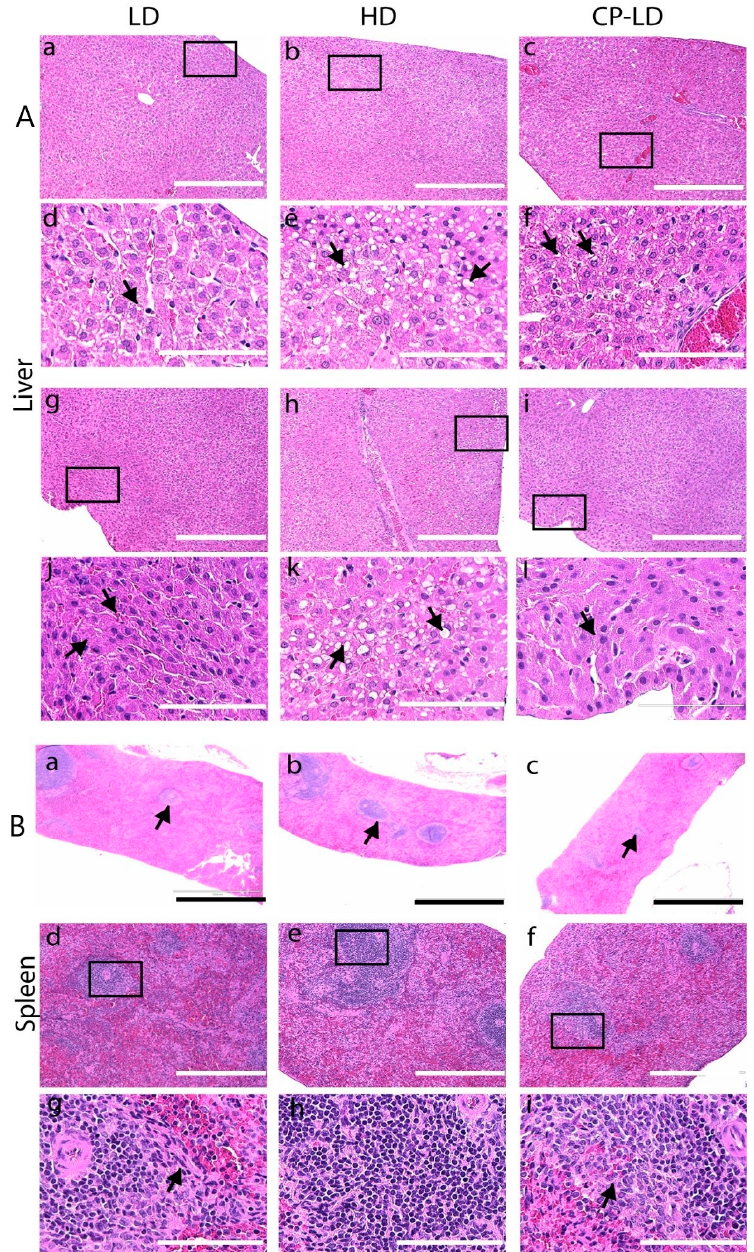
Figure 5. Histopathology of liver ( A ) and spleen ( B ) in SARS-CoV-2-infected hamsters. ( A ): Histopathological analysis of LD, HD, and CP-LD-infected hamster liver (4, 7, and 16 dpi, n = 3 per time point) showed the infiltration of lymphocytes in sinusoids at 4 dpi ( a , d ), and py- knosis (arrows in d ), karyorrhexis, and karyolysis in necrotic hepatocytes ( g , arrows in j ) at 7 dpi. Necrotic hepatocytes with pyknotic nuclei and mild to moderate steatosis ( b , arrows in e ) and severe congestion in the portal vein ( h ) were noted at 4 dpi, while severe congestion in the portal vein, sinusoids, and mild steatosis ( c , arrows in k ) were observed at 7 dpi in HD-infected hamsters. Severe degeneration and necrosis of hepatocytes near the parietal surface were observed at 4 dpi in CP-LD animals ( i, arrows in l ). Images ( a – c , g – i ) are 100 × , and ( d – f , j – l ) are 400 × magnifications. Scale bar represents 100 µ m ( d – f,j – l ), or 400 µ m ( a – c , g – i ). ( B ): Histopathological analysis of the spleen revealed a reduction in the number and area of white pulp lesions and cellular composition with increased trabecular connective tissues at 4 dpi in LD ( a , d , g ), HD ( b , e , h ), and CP-LD ( c , f , i )-infected hamsters. Images ( a – c ) are 40 × , ( d – f ) are 100 × , and ( g – i ) are 400 × magnifications. Scale bar represents 100 ( g – i ), 400 ( d – f ), or 1000 µ m ( a – c